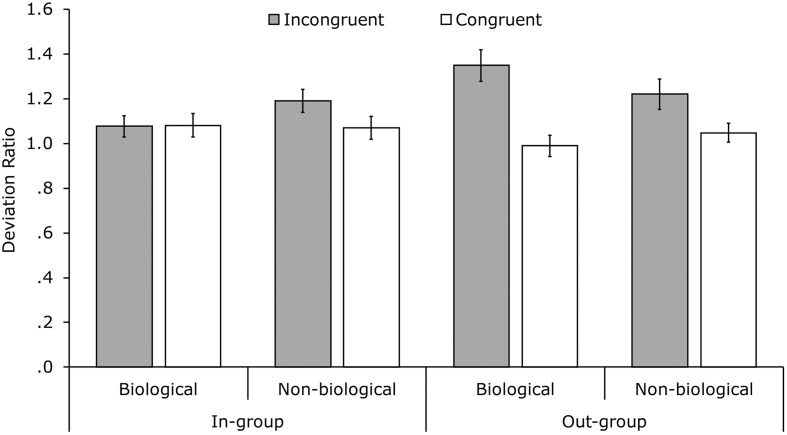
Mean deviation ratios per condition. Deviation ratios were calculated by dividing the standard deviation in the uninstructed direction by the standard deviation in the uninstructed direction from the corresponding baseline trial. Error bars indicate standard errors of the mean.